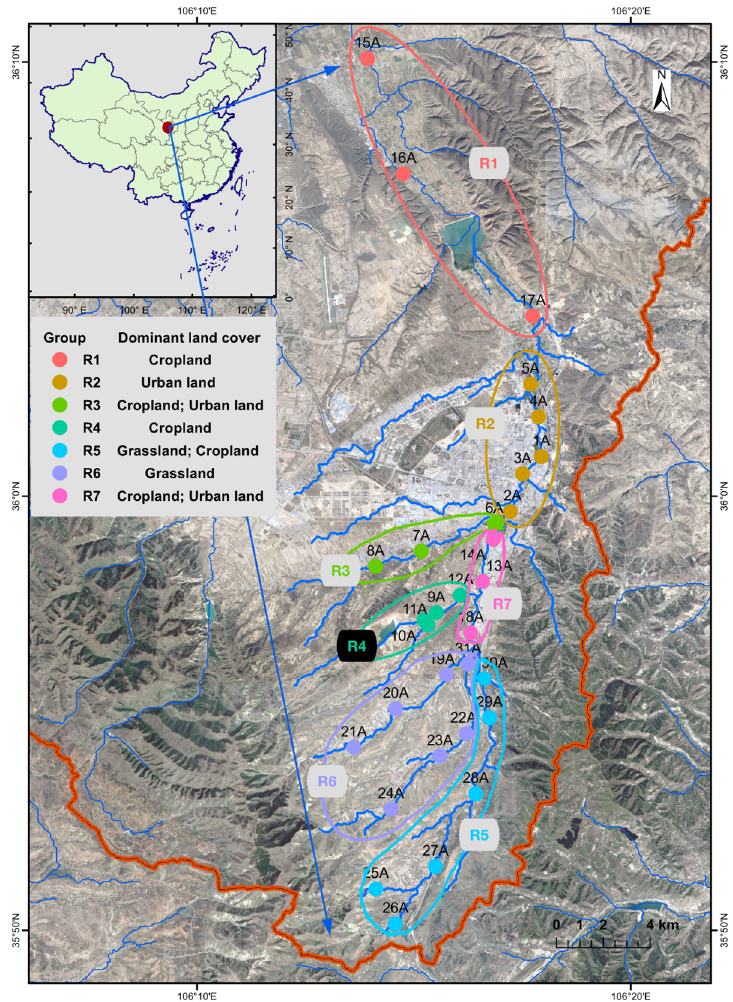
Figure 1. Locations of sampling sites in the Qingshui River.